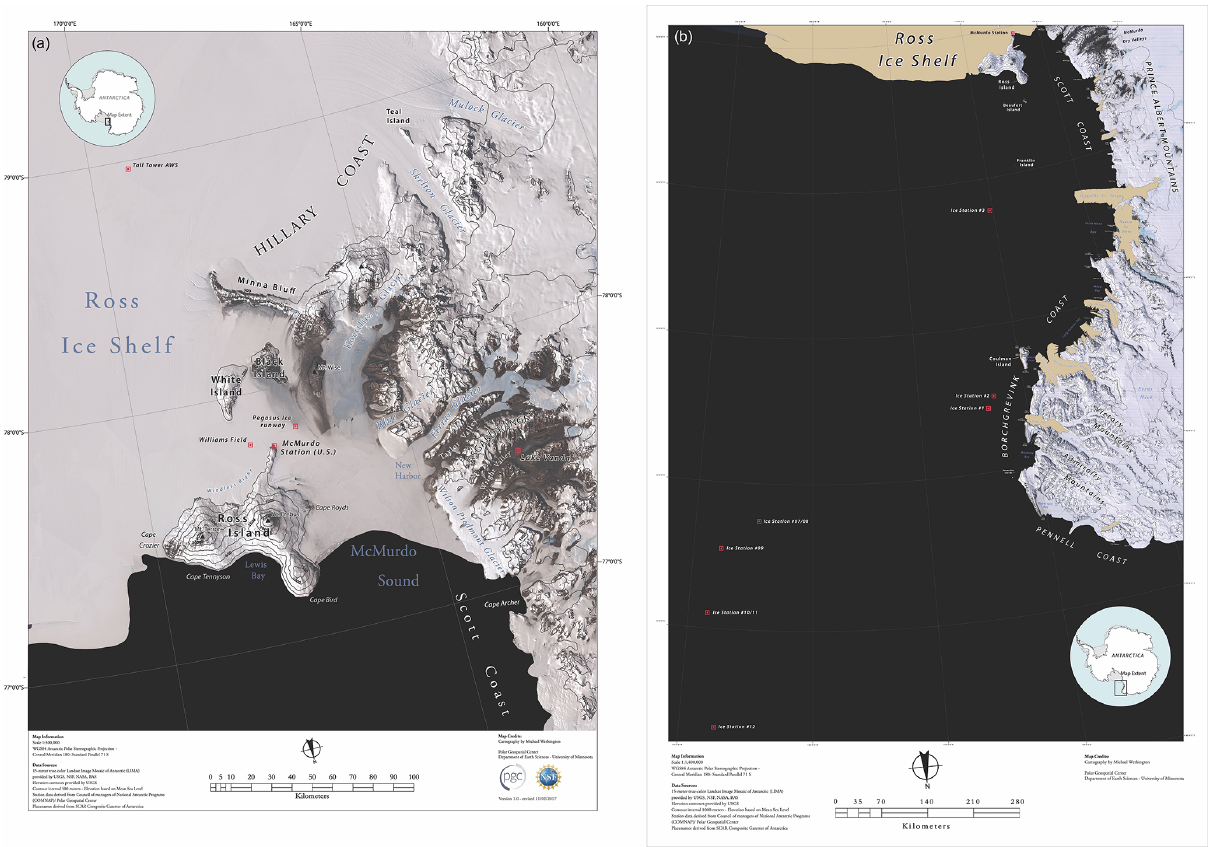
Figure 1. Location of all SUMO sUAS boundary layer flights (red squares) over the Antarctic continent (a) and the Ross Sea (b) . Maps